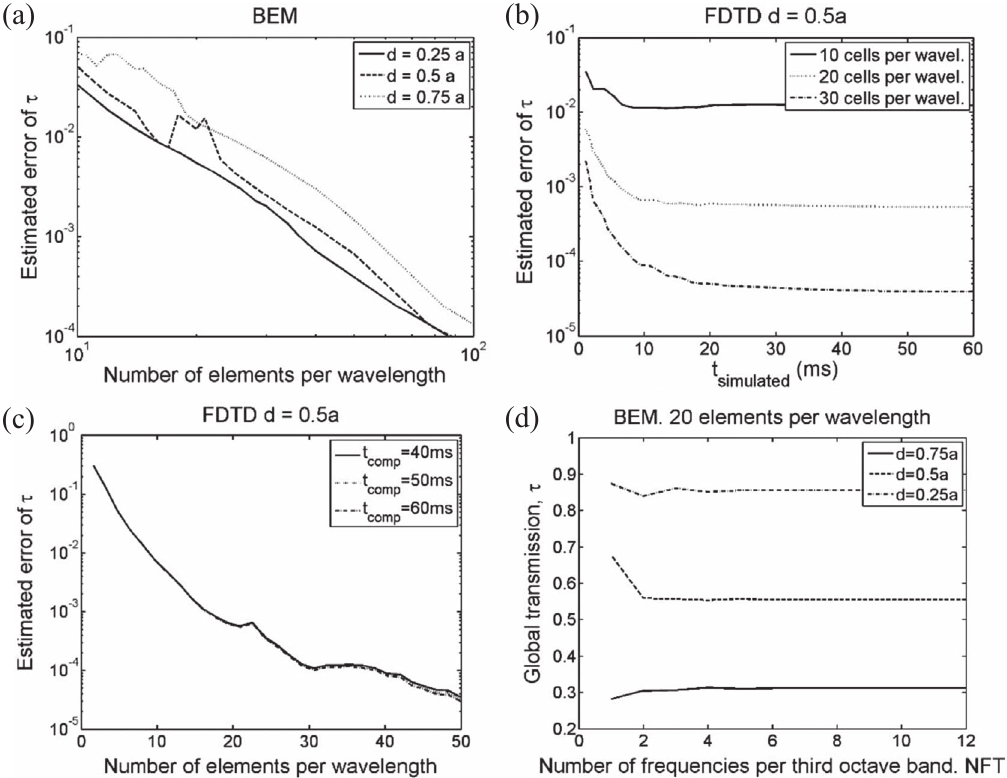
Figure 2. Evolution of the estimated error of the global transmission coef fi cient s (a) in BEM as a function or the number of elements per wavelength, and in FDTD as a function of (b) the time simulated and (c) the number of elements per wavelength. (d) Global transmission coef fi cient versus number of frequencies per third octave band (NFT) in